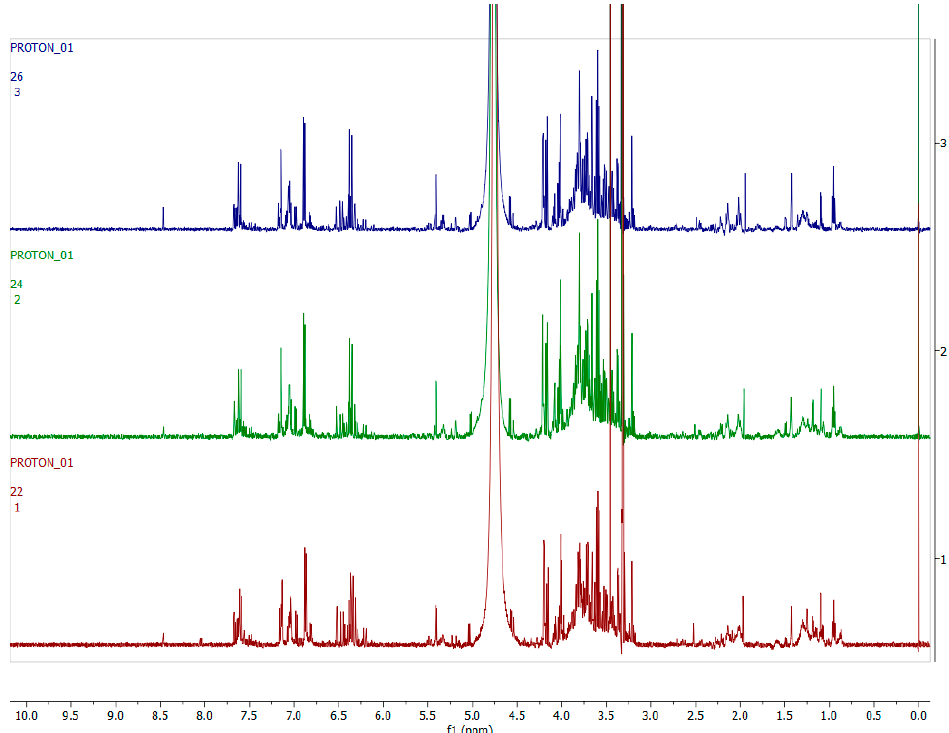
Figure 8. The 600 MHz 1 H-NMR spectra of H. aureonitens leaf extracts collected from the wet and dry sites at Telperion during the spring season. Red = site 1 (wet); green = site 2 (wet); blue = site 3 (dry).